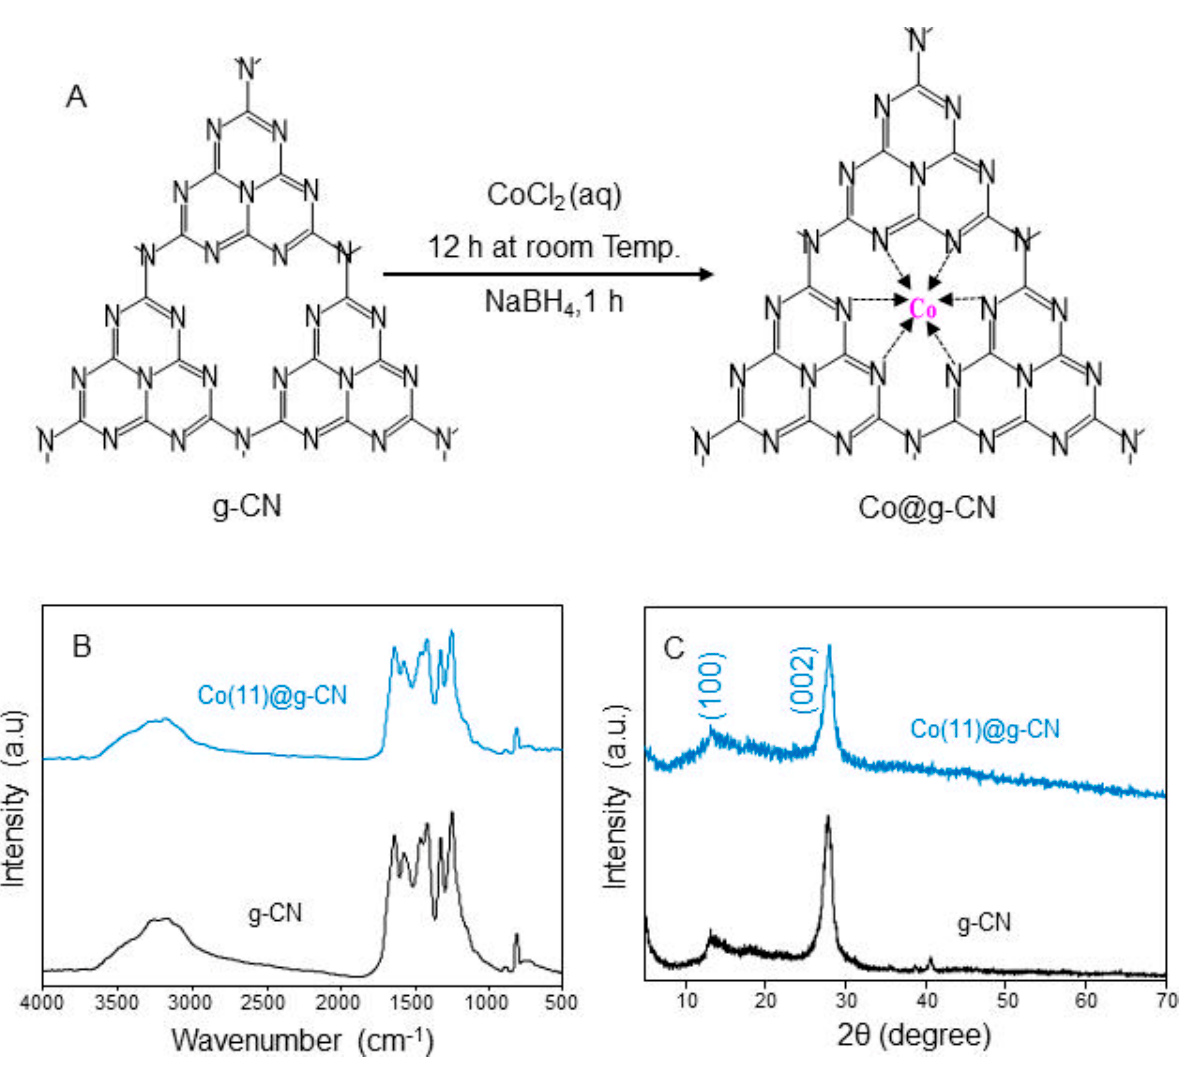
Figure 1. ( A ) Schematic diagram of a synthesis procedure of Co@g-CN from g-CN, ( B ) FTIR spectra and ( C ) XRD patterns of g-CN and Co(11)@g-CN. and ( C ) XRD patterns of g-CN and